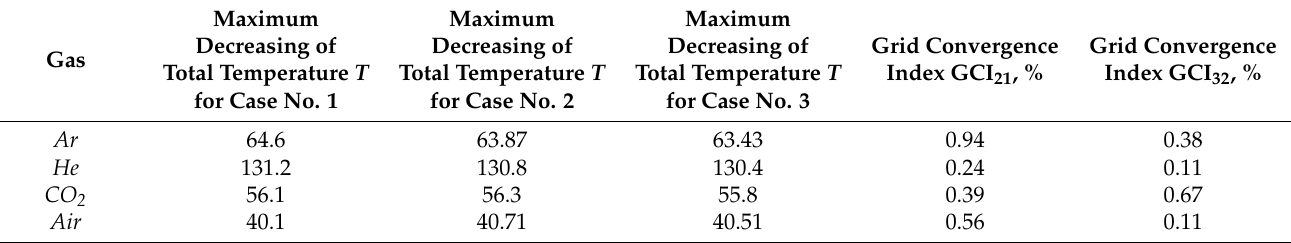
Table 6. Mesh independence study results for SVT with the same